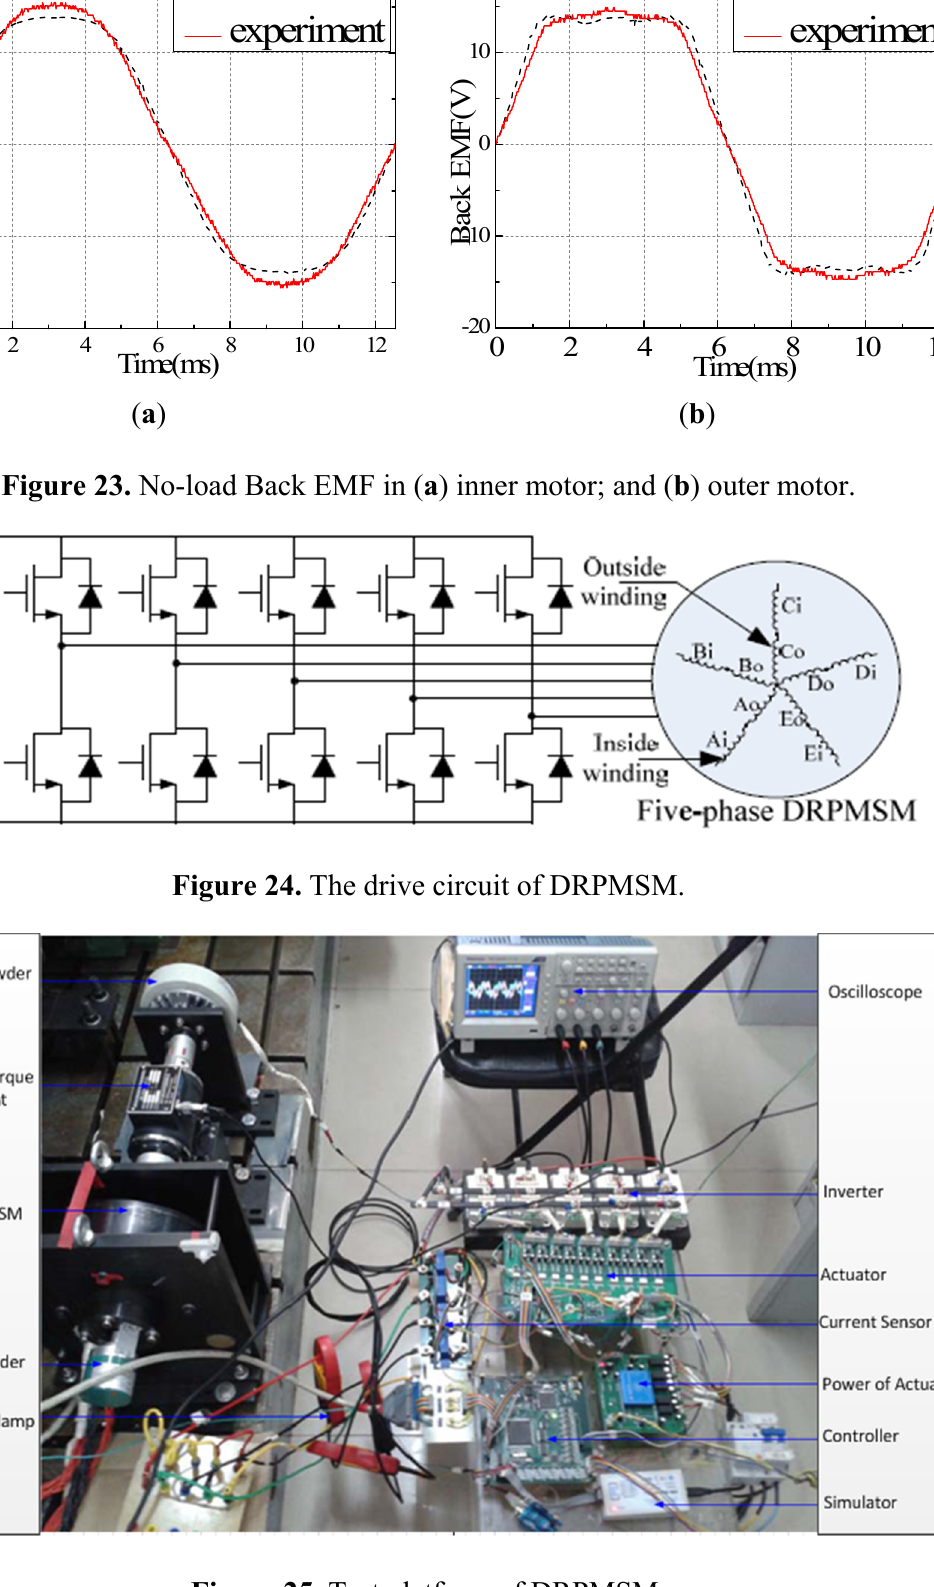
Figure 25. Test platform of